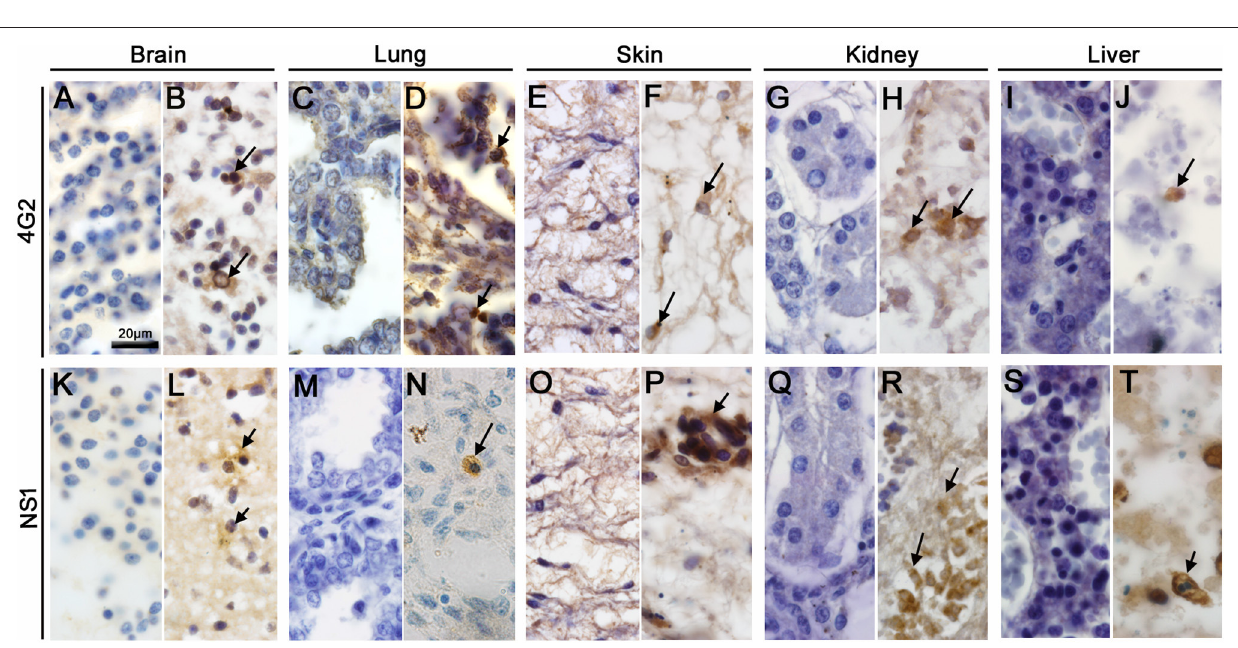
FIGURE 4 | Detection of ZIKV antigens in fetal organs. (B,D,F,H,J,L,N,P,R,T) The flaviviral E and ZIKV-NS1 protein were detected in all tissues studied. (B,L) Microglial cells and neurons of the brain tissue were positive for ZIKV E protein and NS1, respectively. (D,N) ZIKV E and NS1 proteins were detected in alveolar macrophages. (F,P) Section of a skin dermis showed mononuclear cells of an inflammatory infiltrate and endothelial cells stained respectively to ZIKV E and NS1 proteins. (H,R) ZIKV E protein and NS1 detection in macrophages of the kidney. (J,T) Detection of ZIKV E protein and NS1 in hepatocytes, respectively. (A,C,E,G,I,K,M,O,Q,S) The E and NS1 antigens of ZIKV were not detected by immunohistochemistry in the control